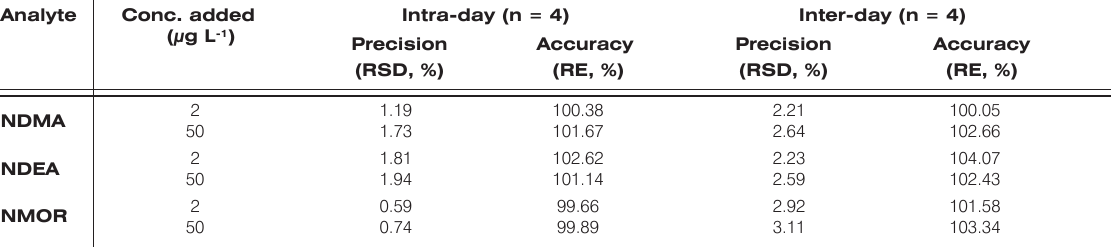
Table 4. Intra-day, inter-day precision, and accuracy values of N-nitrosamines in ultrapure water.